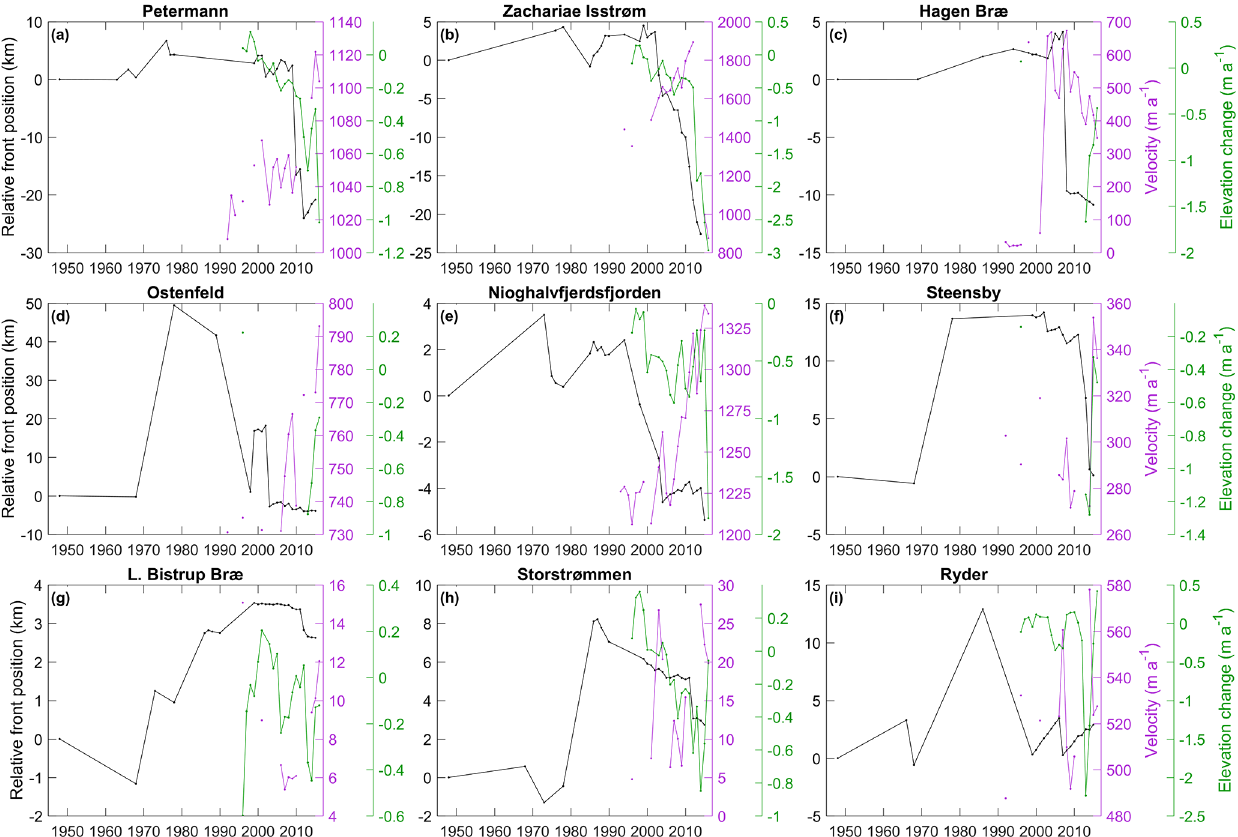
Figure 7. Front position and velocity and elevation change at nine outlet glaciers which terminate in floating ice tongues in northern Green- land. Left axes show front position (black line) between 1948 and 2015 relative to their initial position in 1948; right axes show grounding-line velocities (purple) on between 1996 and 2015. Surface elevation changes averaged across the glacier centre line profile (green) for 1996 to